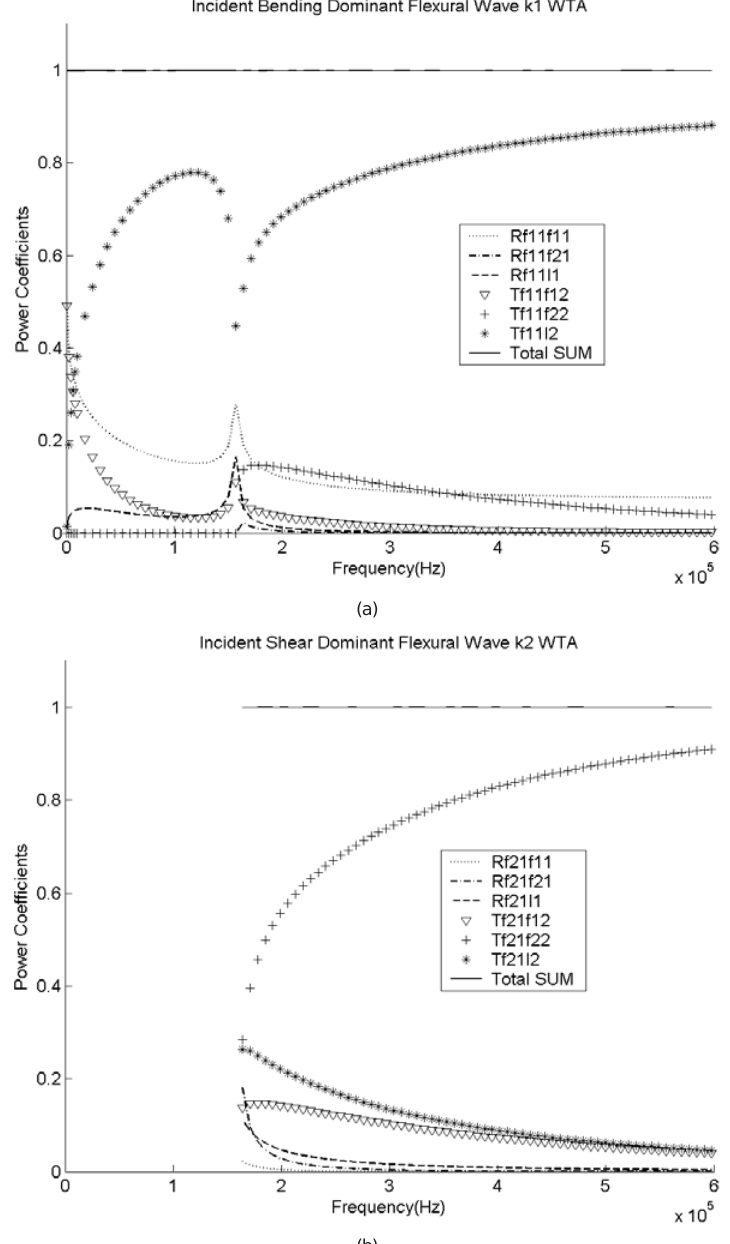
Fig. 6. The power transmission and reflection coefficients of two semi-infinite Timoshenko beams with the same material and geometrical properties joined at 90 ◦ : (a) Case of the incident BDFW with wavenumber k 1 , (b) Case of the incident SDFW with wavenumber k 2 , (c) Case of the incident longitudinal